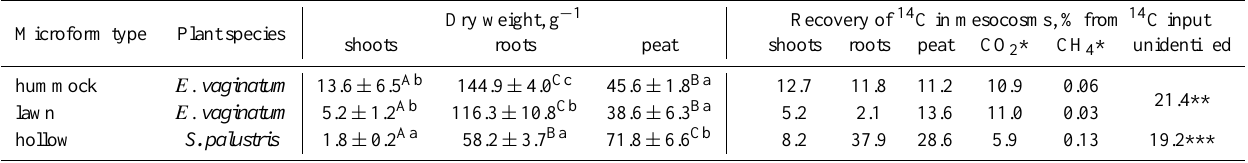
Table 1. Dry weight ( ± SE, n = 12) and the recovery of 14 C label in compartments of mesocosms of Eriophorum vaginatum ( E . vaginatum from hummocks and lawns) and Scheuchzeria palustris ( S. palustris from hollows) after 18 days of the experiment. Microform type